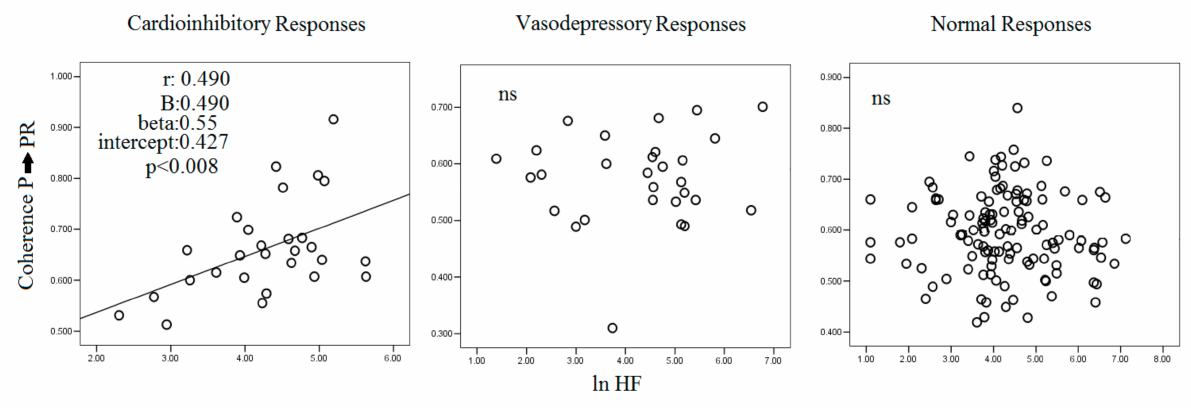
Figure 5. Relation between P → PR coherence and natural logarithm of high frequency (HF) power detected from RR spectral analysis. HF is marker of sinus vagal control. A positive correlation was found in the in subjects with a cardioinhibitory